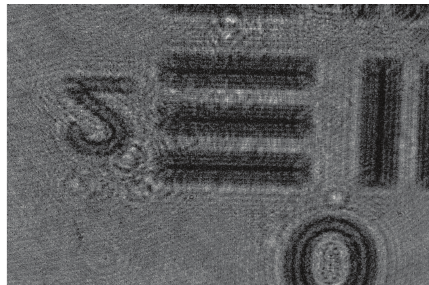
Figure 5: Recording of digital hologram.